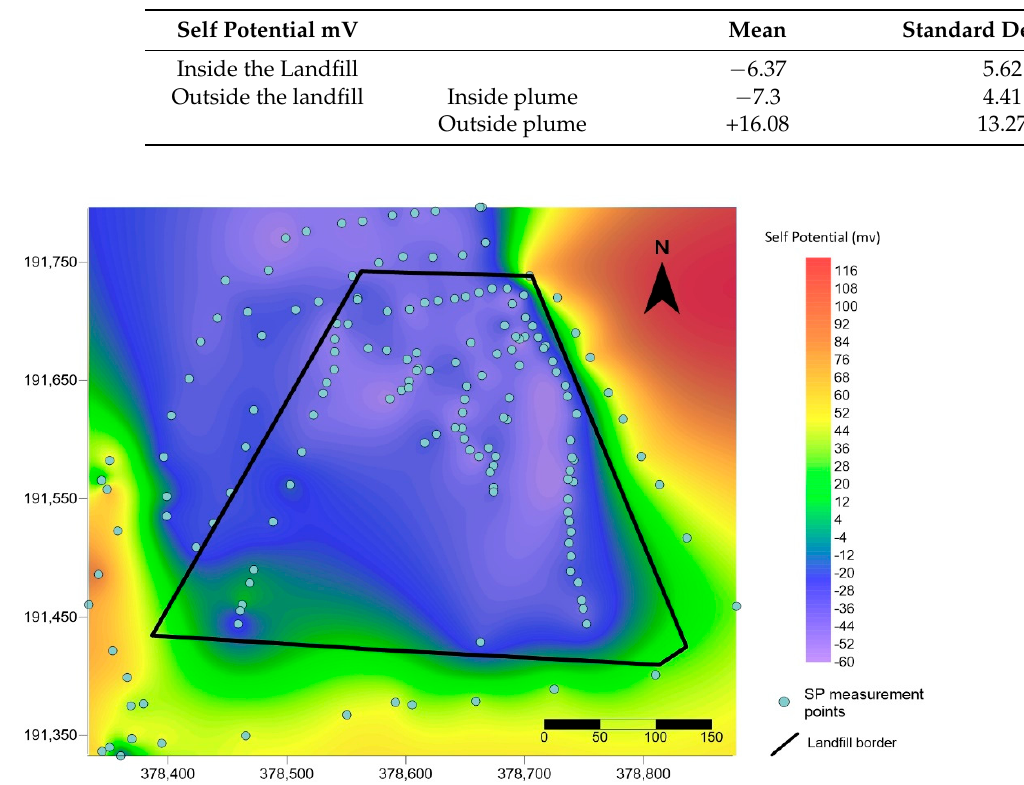
Figure 3. Survey regrouping of self-potential results obtained during the 3 measurement campaigns in and around the landfill. UTM coordinates in metre using Lambert conical conformal projection (Morocco zone 1).